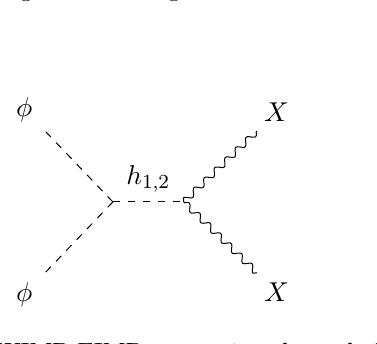
Figure 16 . Feynman diagrams showing annihilation channels of φ aEWSB.